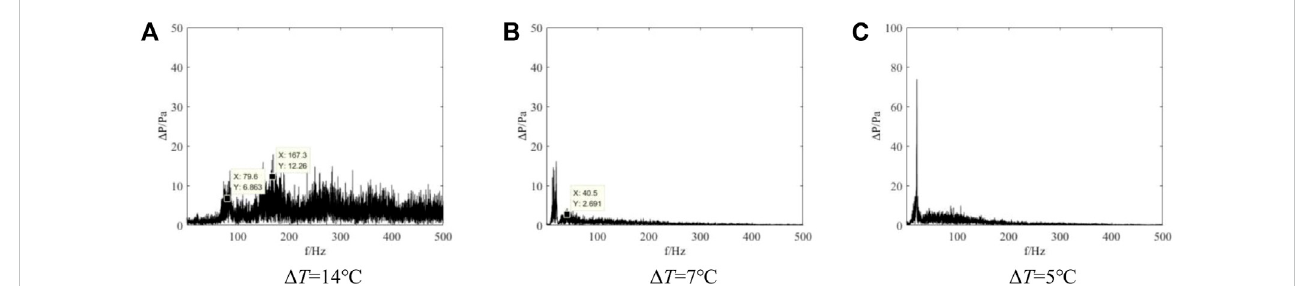
Noise frequency-domain signal when Ge = 70 kg/m 2 · s.